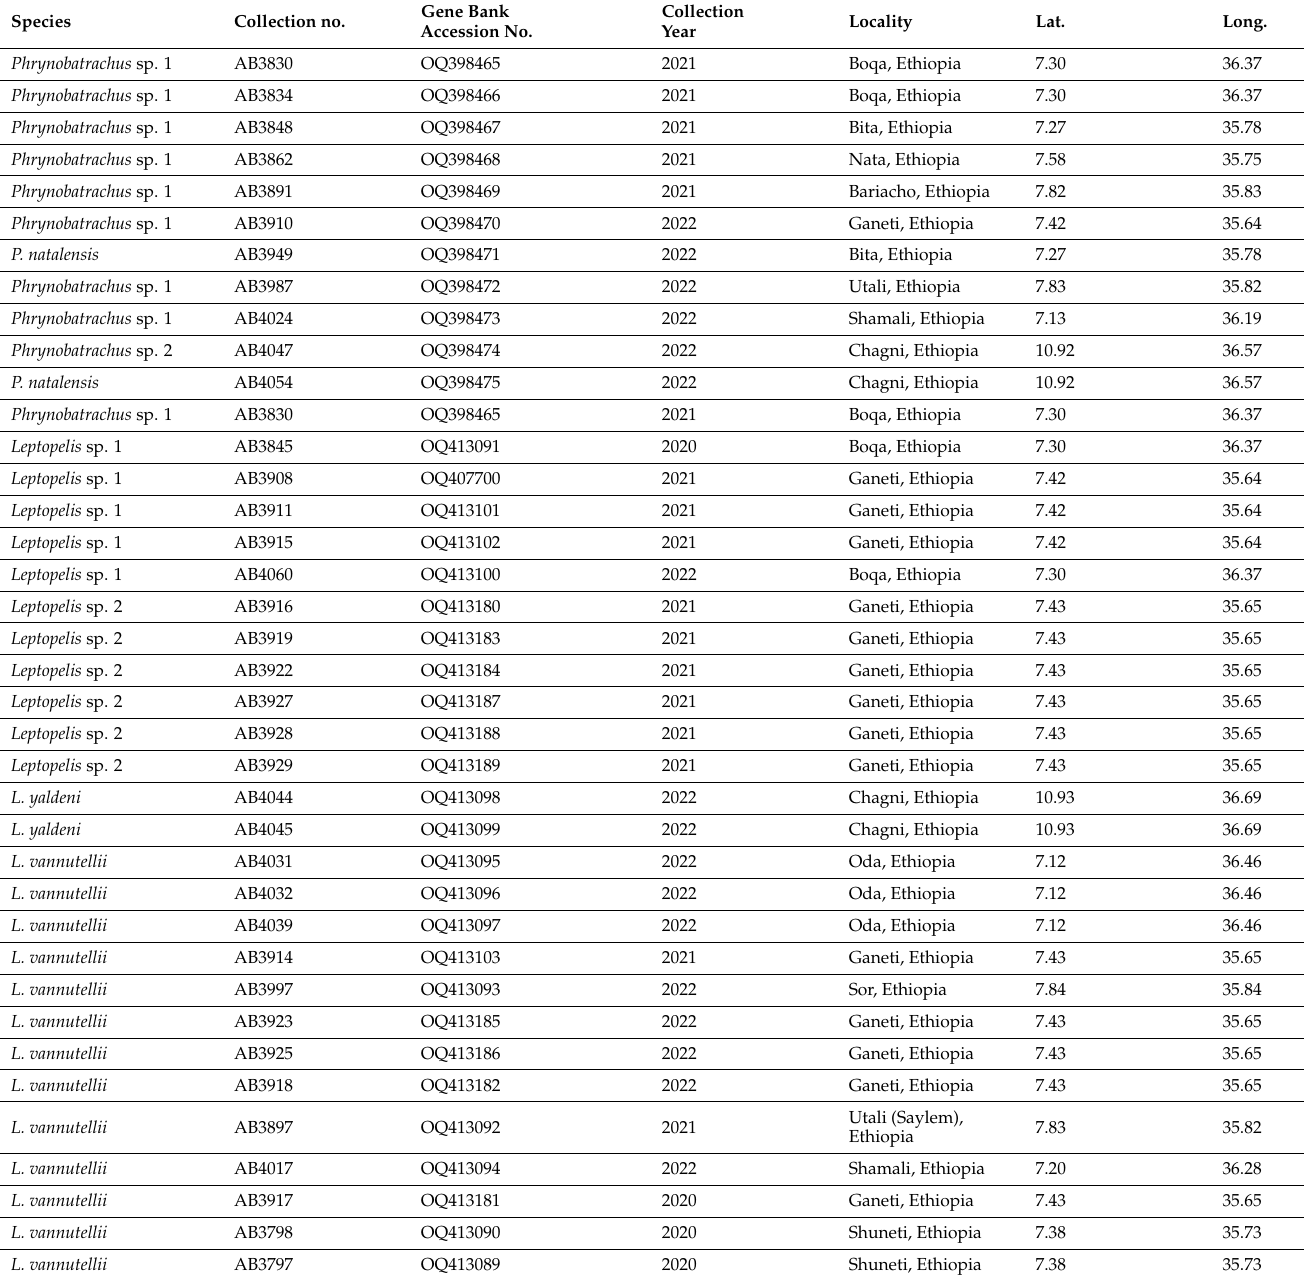
Table 1. Localities, collection, and GeneBank accession numbers of the taxa sequenced in this